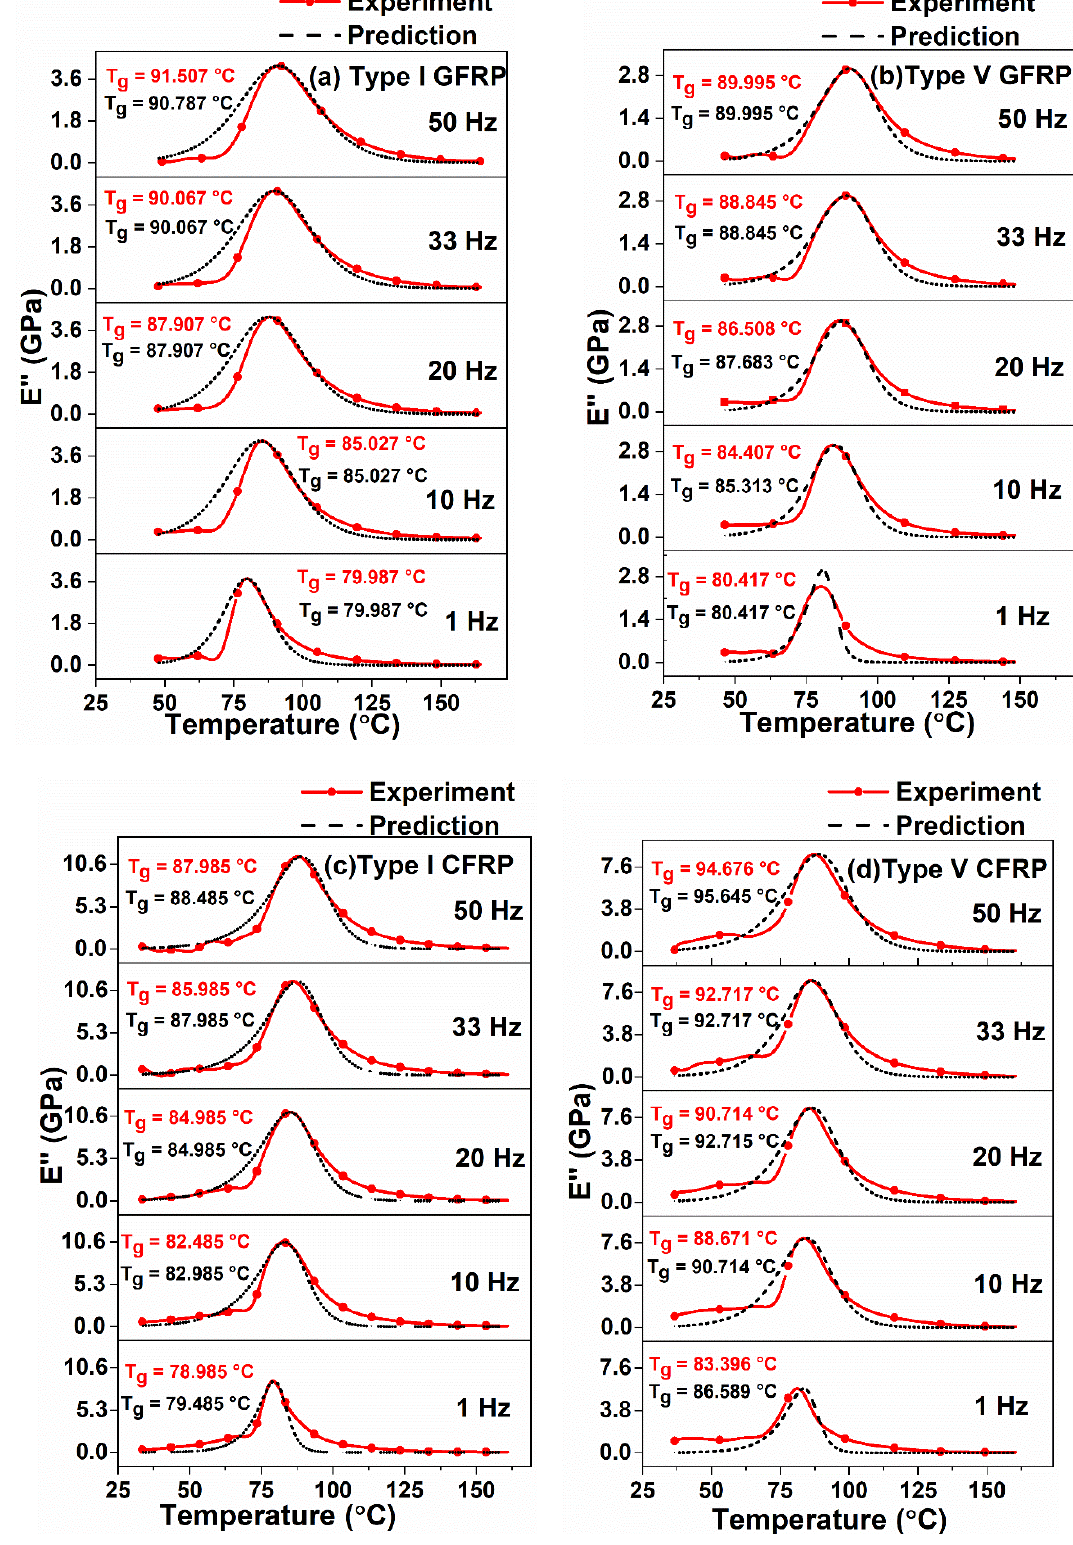
Figure 9. Comparison of predicted loss modulus values with the experimental values for different frequencies: ( a ) Type I GFRP, ( b ) Type V GFRP, ( c ) Type I CFRP and ( d ) Type V CFRP.